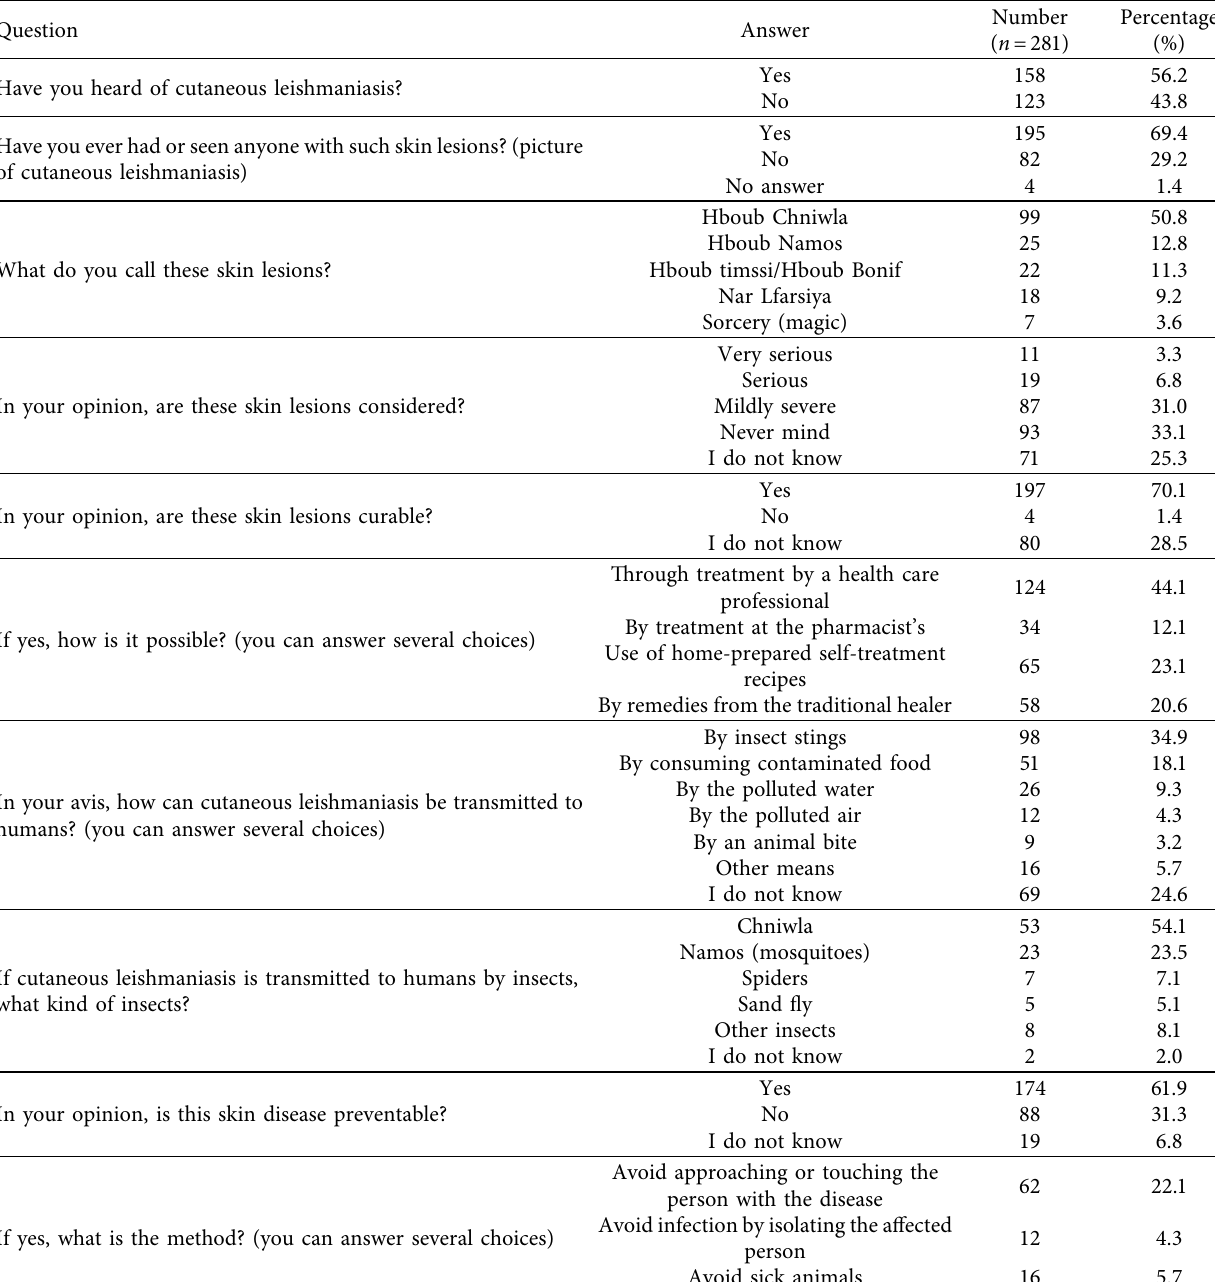
Table 2: Citizens’ knowledge and beliefs about cutaneous